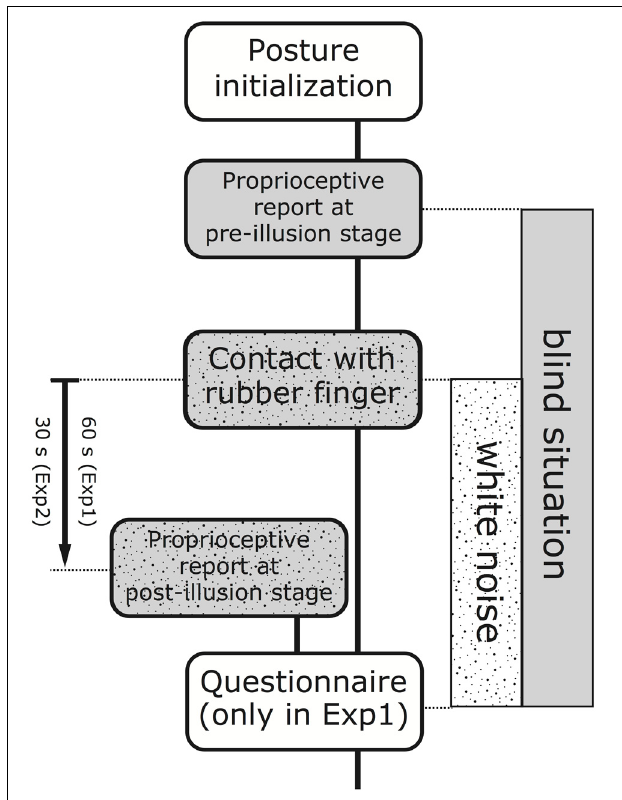
FIGURE 3 | Experimental procedure in one session. One session comprises “Posture initialization,” “Proprioceptive report at pre-illusion stage,” “Contact with rubber finger,” “Proprioceptive report at post-illusion stage,” and “Questionnaire” in order, where “Proprioceptive report at post-illusion stage” begins without interrupting “Contact with rubber finger.” Each participant engaged in the “Proprioceptive report at pre-illusion stage” with eyes closed and “Contact with rubber finger” (including “Proprioceptive report at post-illusion stage”) with eyes closed and while hearing white noise through a wireless headphone. “Questionnaire” was replaced with a simple operation of counting to 5s in one’s head with both hands folded on one’s lap in Experiment II. The length of time from the beginning of the “Contact with rubber finger” until the beginning of “Proprioceptive report at post-illusion stage” was 60s in Experiment I but 30s in Experiment